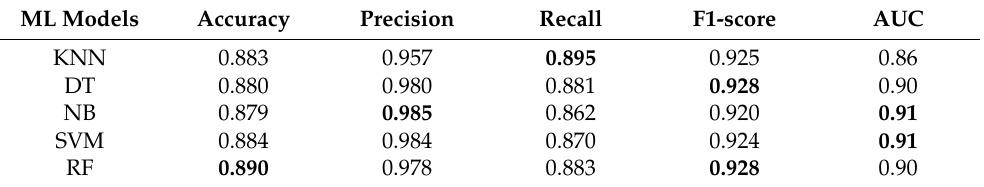
Table 3. Performance Prediction of all ML Models for